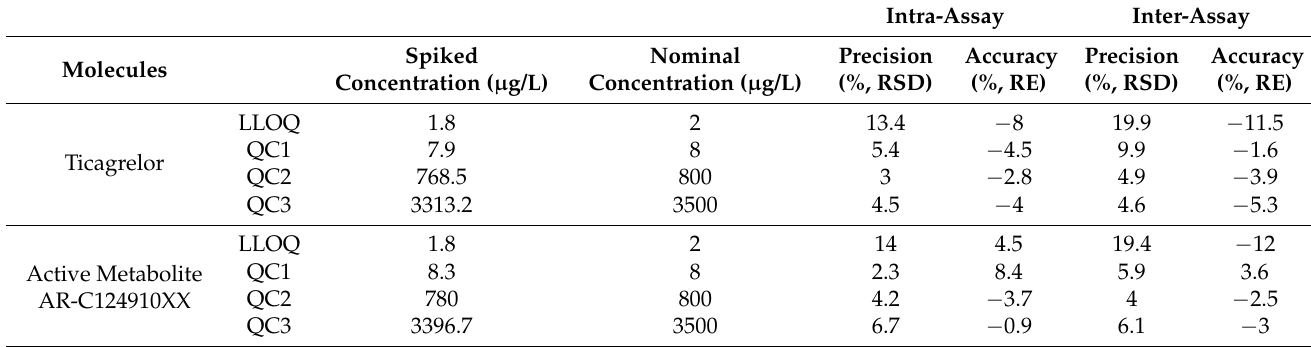
Table 1. Intra- and inter-assay precision and accuracy for ticagrelor and its metabolite